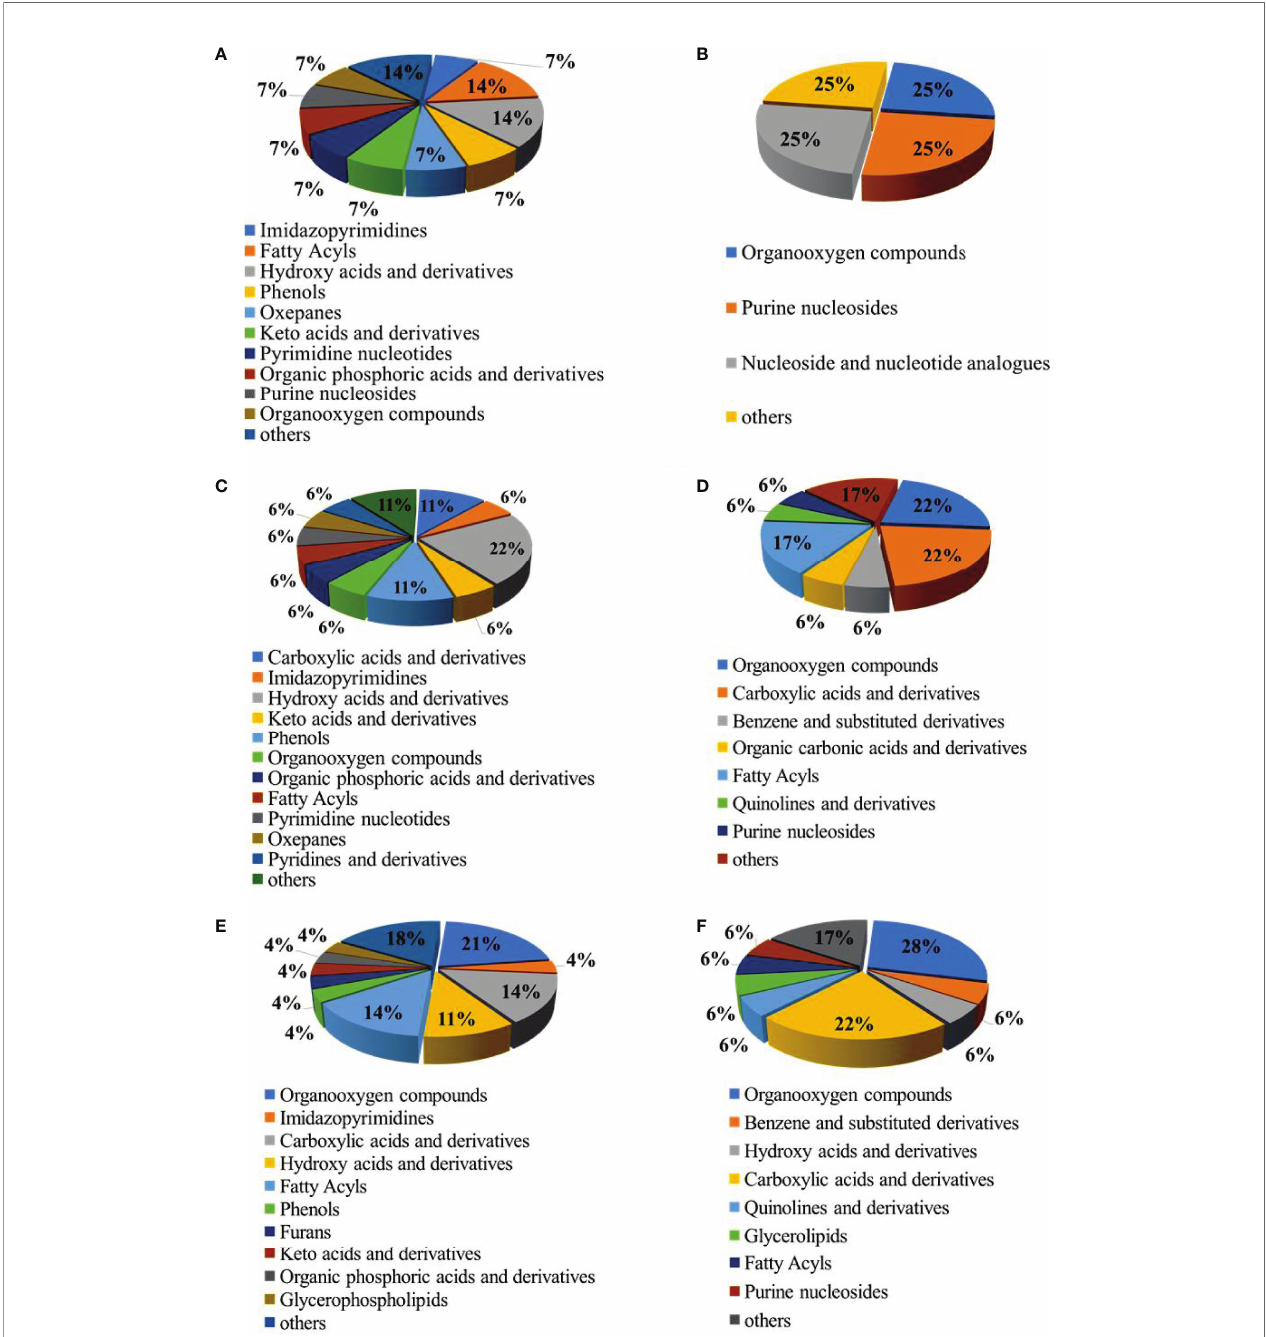
FIGURE 4 | The pie chart of the differential metabolite classi fi cation: Up-regulated metabolites in gills of LCvsNC group (A) , MCvsNC group (C) and SCvsNC group (E) ; down-regulated metabolites in gills of LCvsNC group (B) , MCvsNC group (D) and SCvsNC group (F)